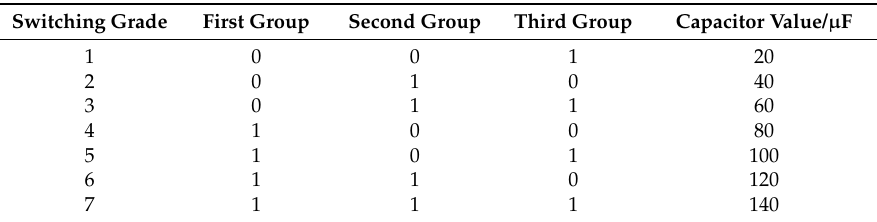
Table 3. Capacitor input grade and switching configuration.